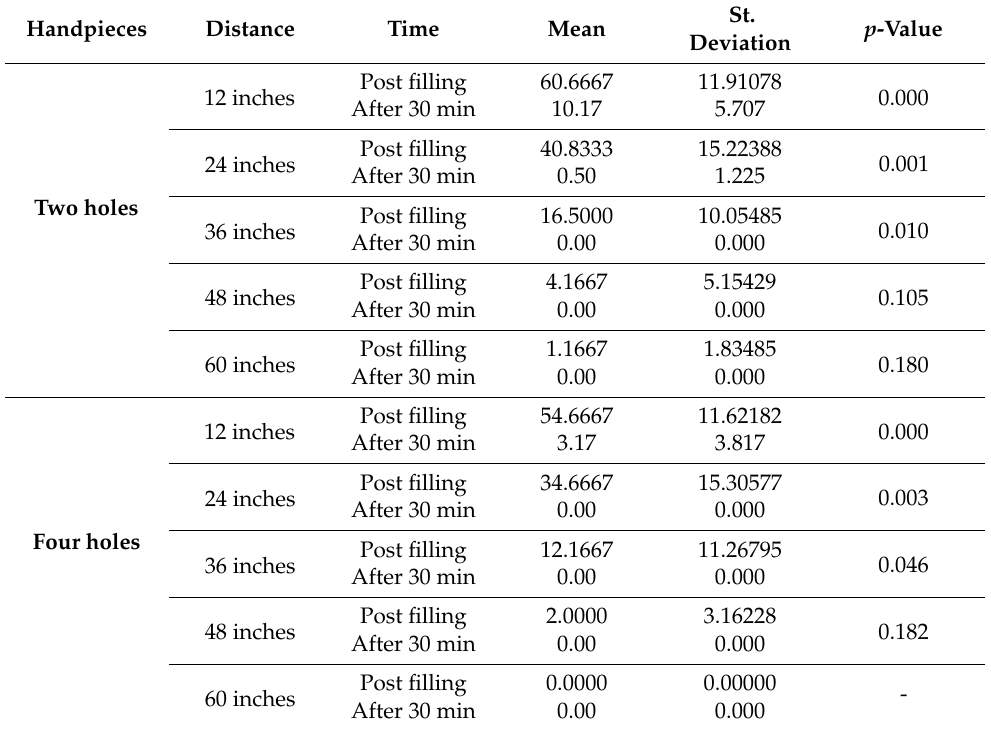
Table 4. Comparison of the mean aerosol and splatter produced immediately after cavity preparation and 30 min after cavity preparation using a two-hole and four-hole